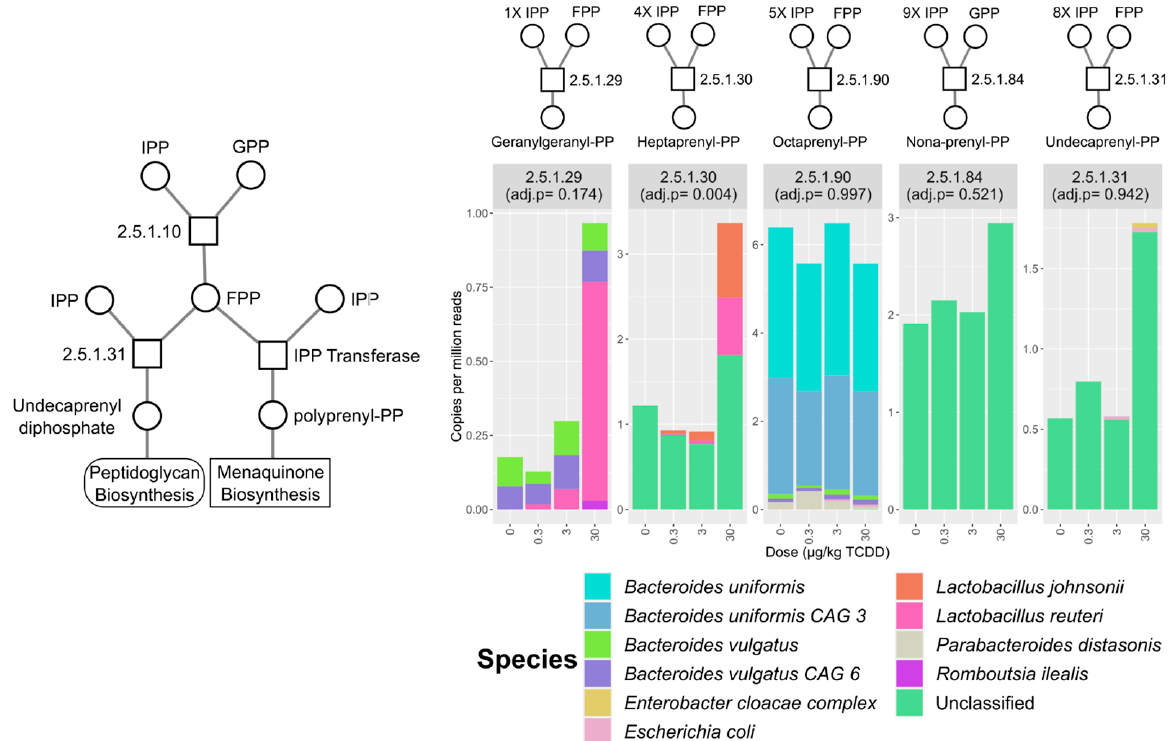
Figure 5. Relative abundance of polyprenol transferase EC annotations identified in the mouse cecum metagenomic dataset. Stacked bar plots represent mean relative abundance of grouped EC numbers ( n = 3) and represent identified species that contributed to mean total abundance for each treatment group. The number of isopentenyl diphosphate (IPP) and farnesyl diphosphate (FPP) molecules used for respective polyprenol biosynthesis are also denoted. Adjusted p -values were determined by the Maaslin2 R package. Abbreviations: isopentenyl diphosphate (IPP), geranyl diphosphate (GPP), polyprenyl diphosphate (polyprenyl-PP).